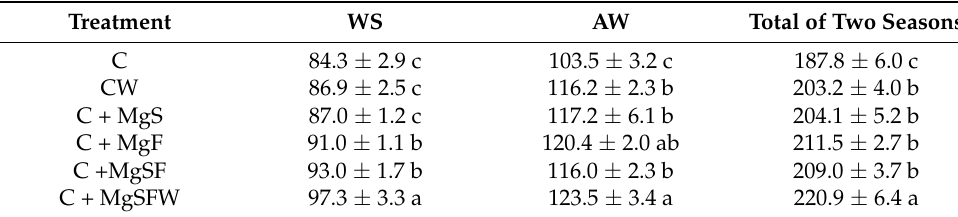
Table 5. Tomato yield under different treatments of Mg fertilizers application (t ha − 1